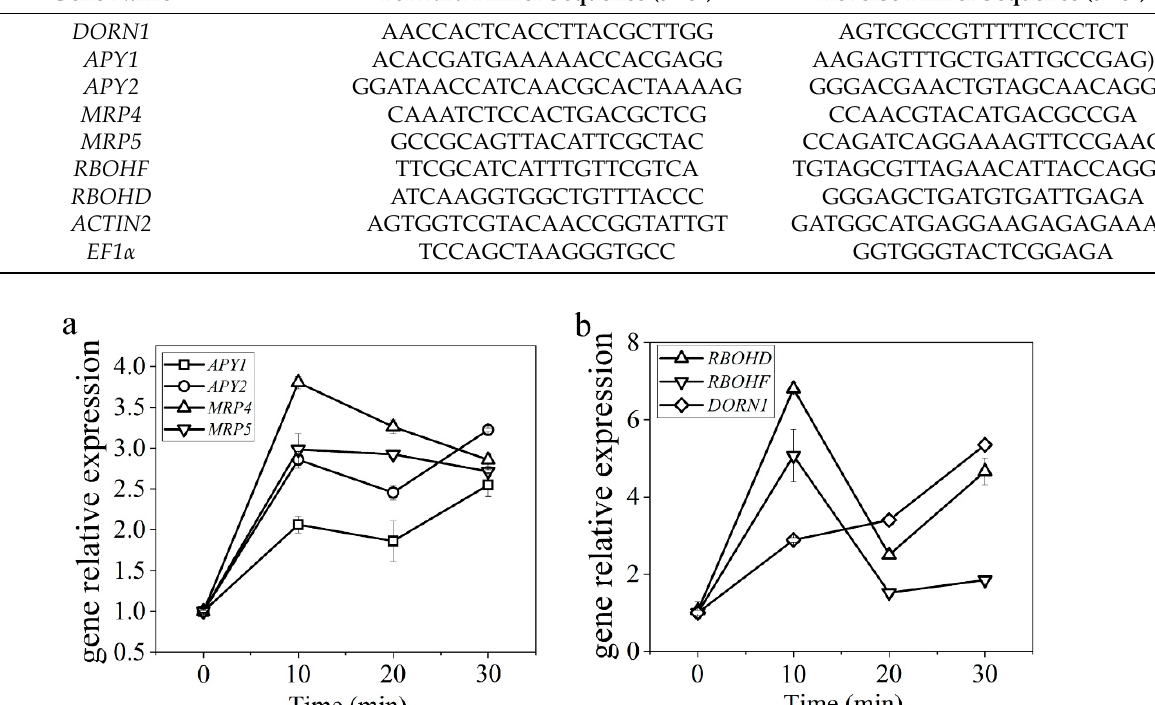
Figure 3. Expression analysis of eATP/H 2 O 2 -related genes. ( a , b ) Relative gene expression levels of MRP4 , MRP5 , APY1 , APY2 , DORN1 , RBOHD , RBOHF in leaves of two-week-old WT Arabidopsis under evk treatment and each group had three technical replicates, and bars represented standard error of the mean. Error bars denote ± SEM, n ≥ 3.